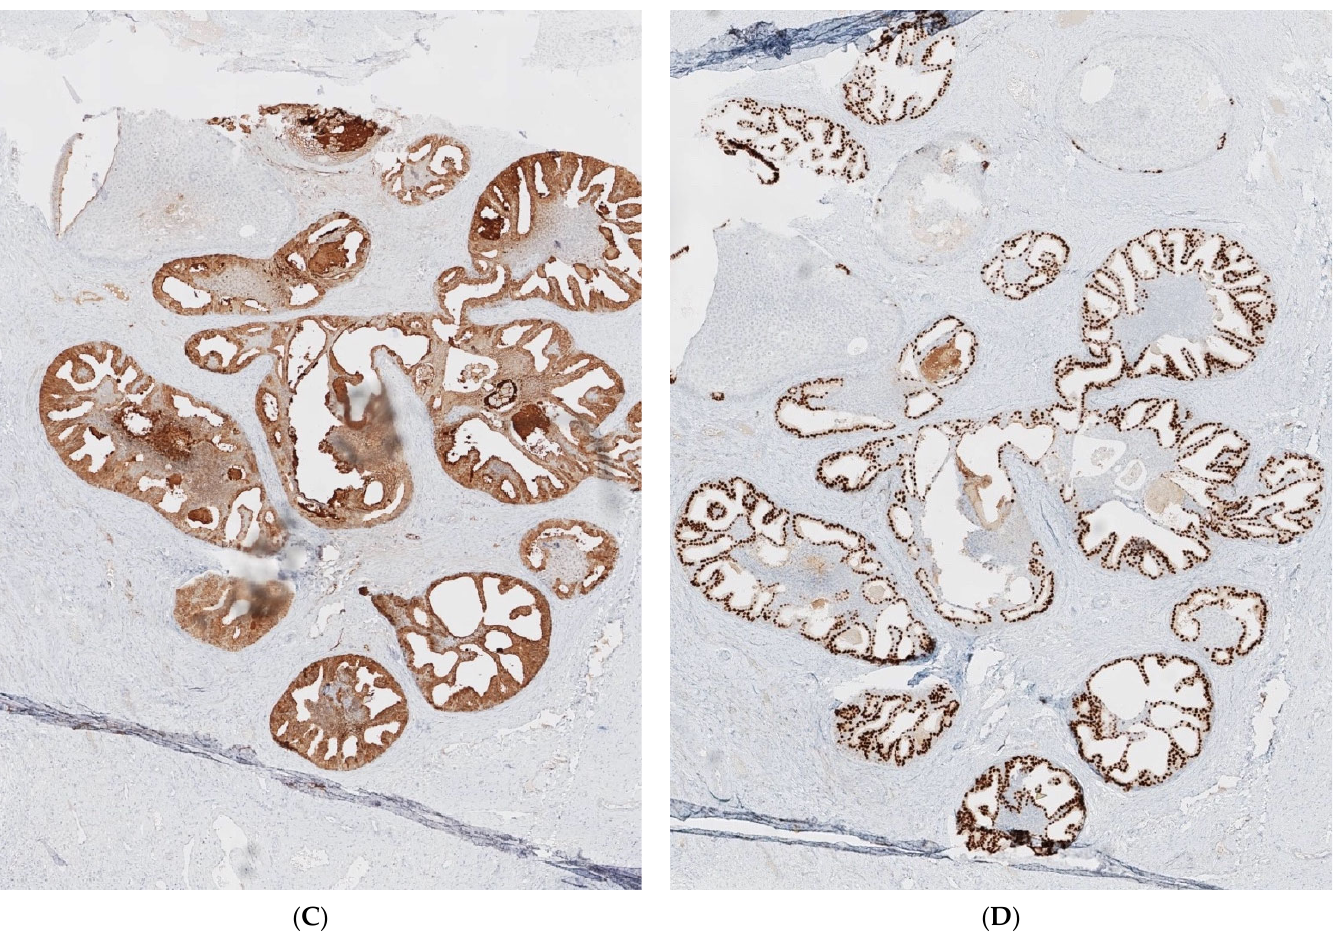
Figure 2. Histological features of the conisate. Histologic features of cervix tissue in HE staining with normal ecto- and endocervix in most specimens ( A ). Histologic features of ectopic prostate tissue with gland ducts in HE staining ( B ) and diffuse positivity in immunohistochemical testing with PSA ( C ) and NKX3.1 ( D ).